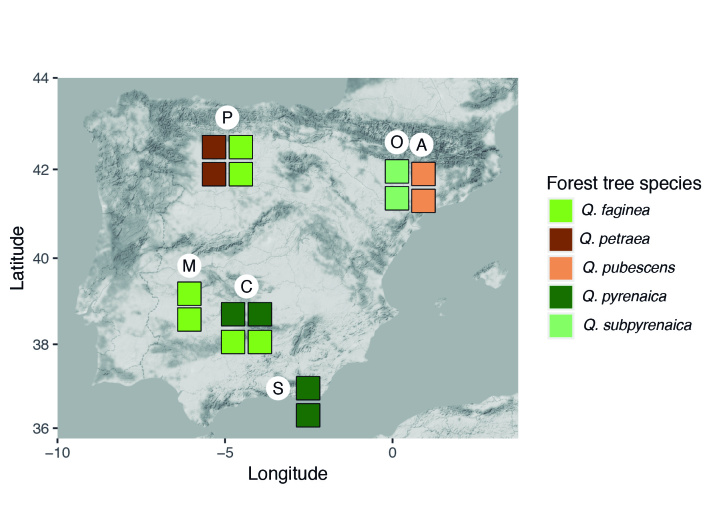
Map of the Iberian Peninsula with the location of the national parks and the plots where the sampling protocol COBRA was applied. For each park, squares denote the number of plots and the oak forest type (colour code labels in the inset). Northern parks are Picos de Europa (P), Ordesa (O), Aigüestortes (A). Southern parks Monfragüe (M), Cabañeros (C), Sierra Nevada (S). See Table 1 for additional information on plots and parks.